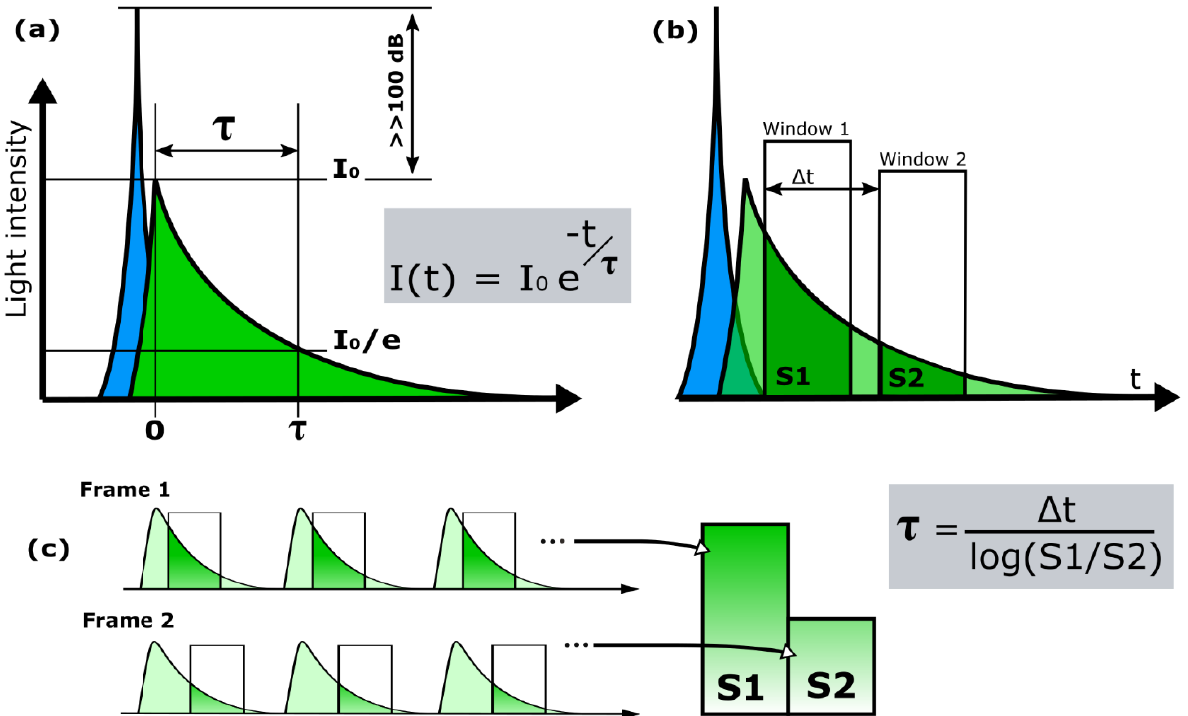
Figure 13. Fluorescence lifetime ( τ ) definition ( a ) 2-window gated lifetime measurement ( b ) and (practical implementation of the 2-window method for a gated camera ( c ).